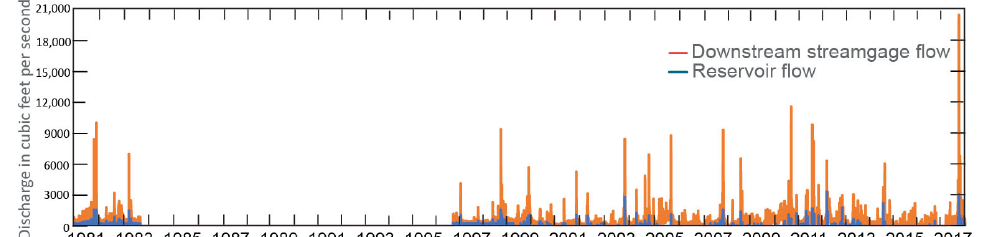
Figure 6. Computed Lago Dos Bocas reservoir releases and observed flow (including reservoir flows) at Río Grande de Arecibo at Cambalache.